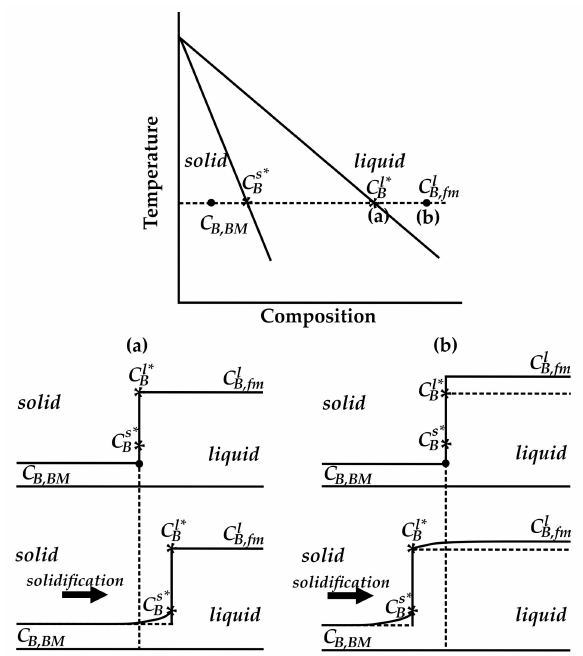
Figure 19. Boundary conditions at the solid-liquid interface during isothermal solidification. The dotted line indicates the initial position of the s / l interface, when ideally solid and liquid are contacted at the instant of the brazing temperature. In case ( a ), a new solid is immediately created, while in case ( b ), to achieve equilibrium at the s / l interface, some melting of the solid occurs before isothermal solidification